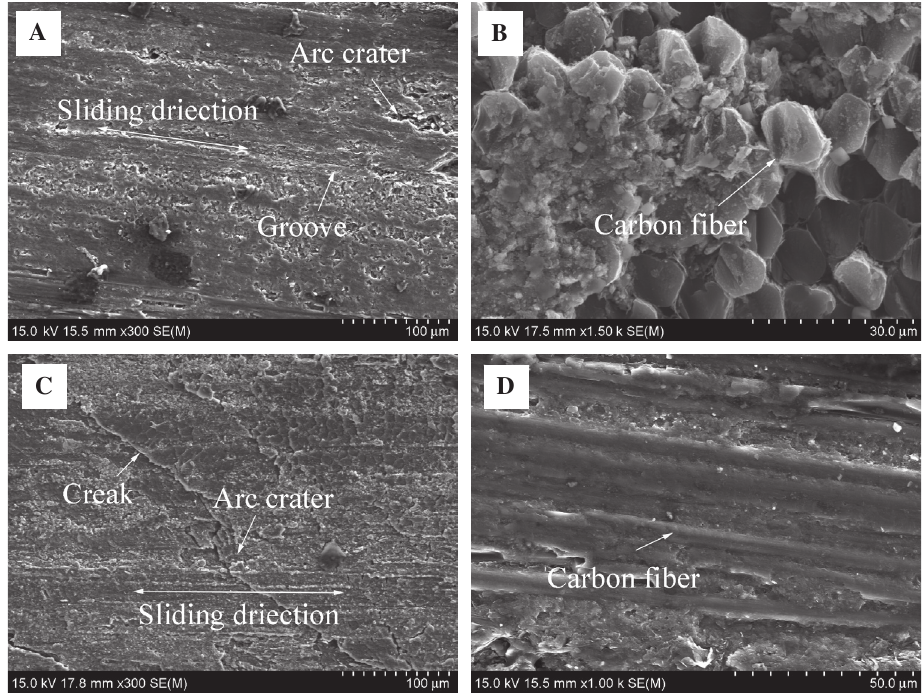
Figure 13 SEM graphics for specimen. (A) and (B) SEM photo untreated; (C) and (D) SEM photos after treatment at 800 °